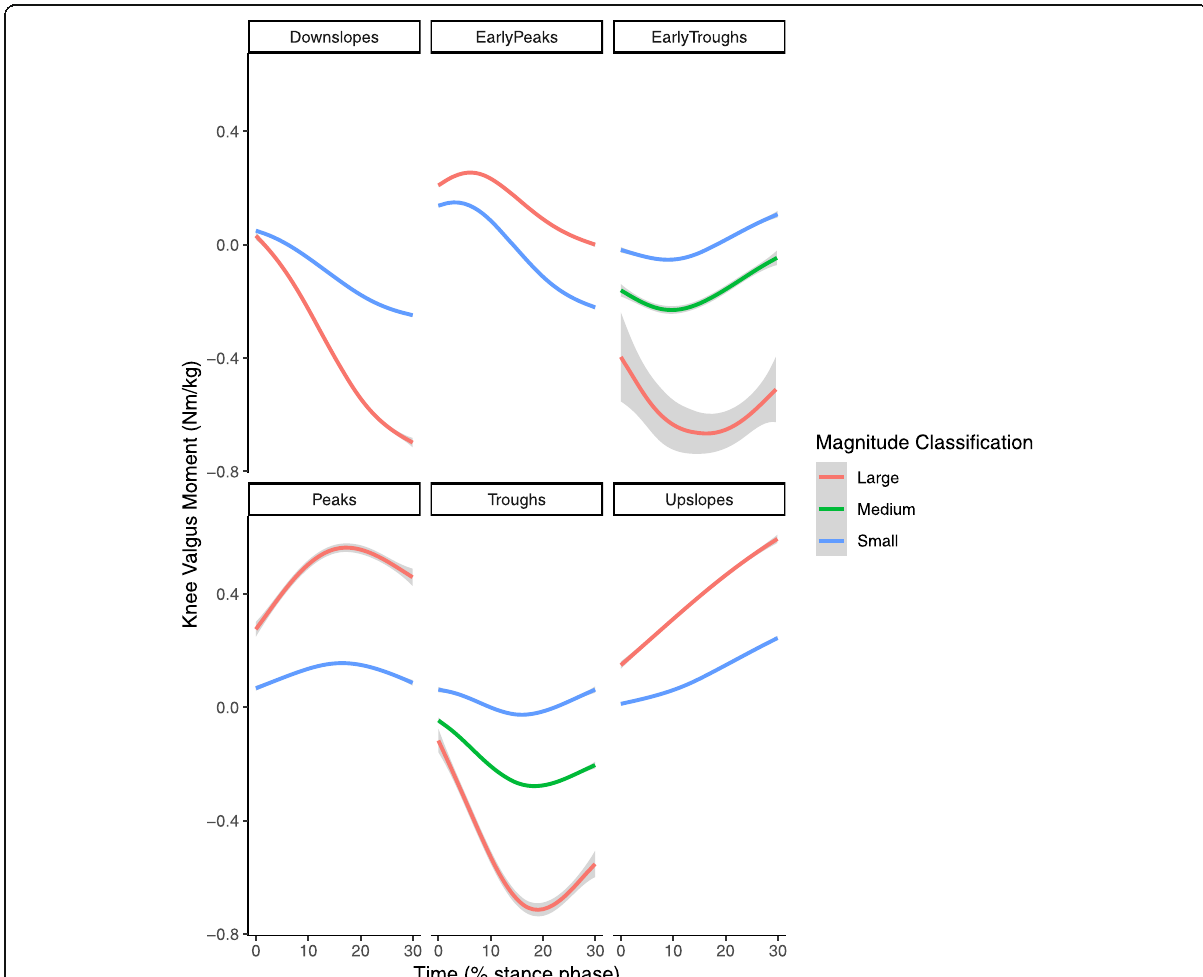
Fig. 5 Smoothed aggregates of the time series of the first 30% of the stance phase of all clusters generated with the two step cluster analysis. The gray shaded area denotes the 95% confidence interval from the smoothing